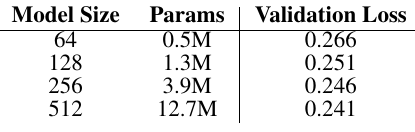
Table 3. Ablation on upsampler model